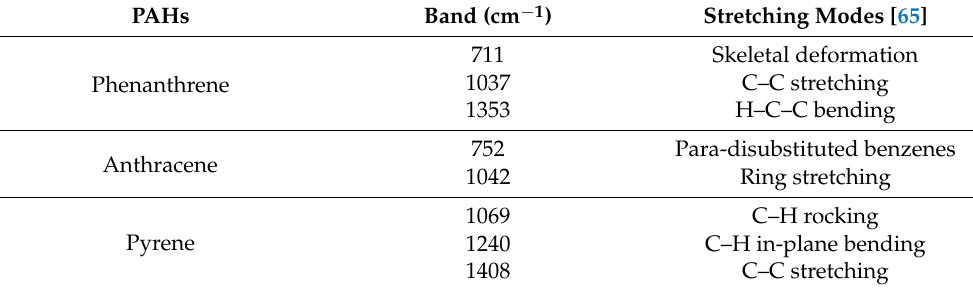
Table 1. The stretching modes correspond to the characteristic peak of